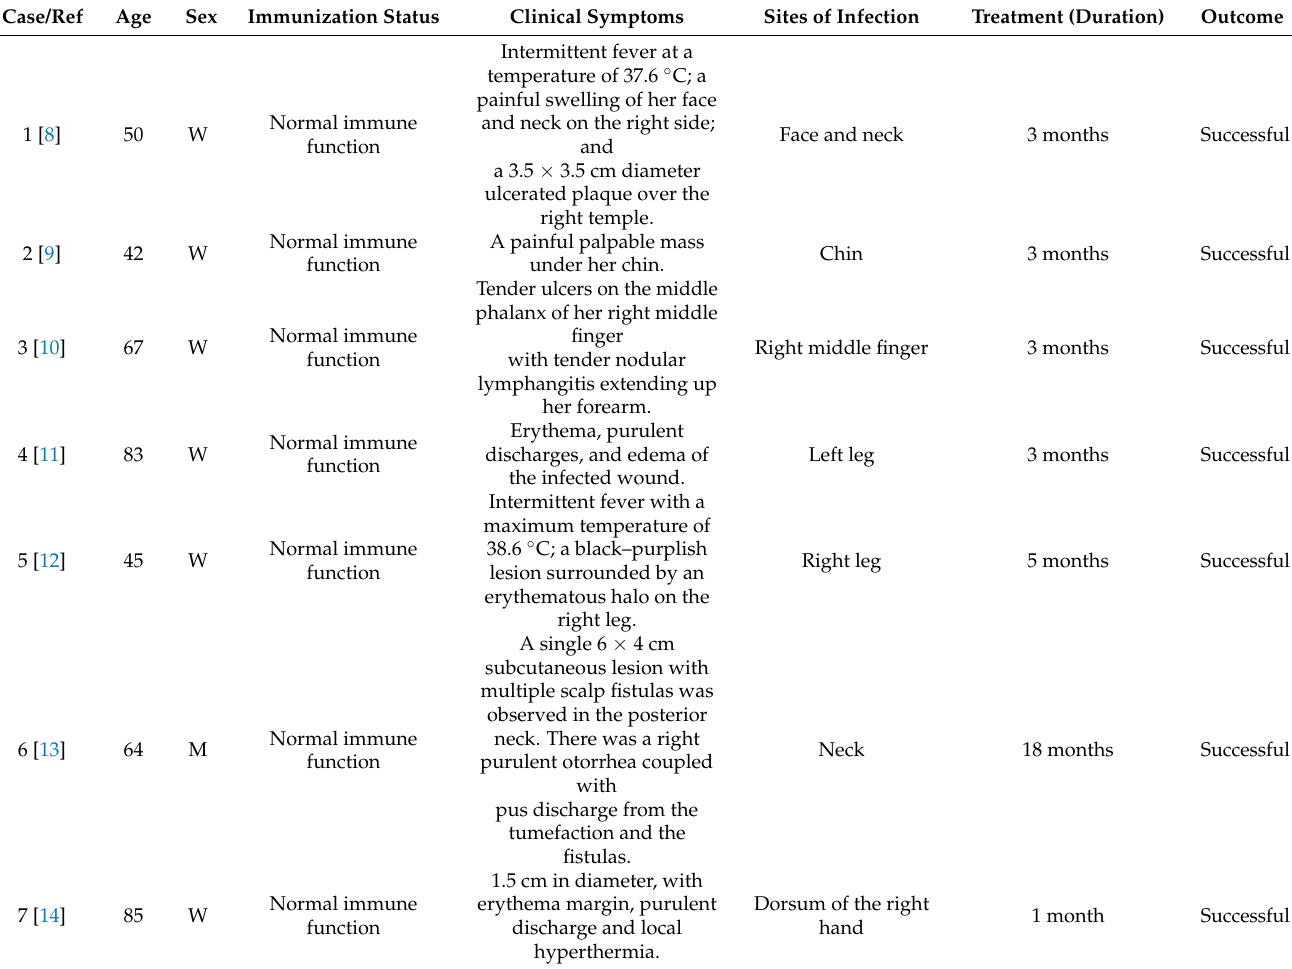
Table 1. Clinical characteristics of seven cases of Nocardia